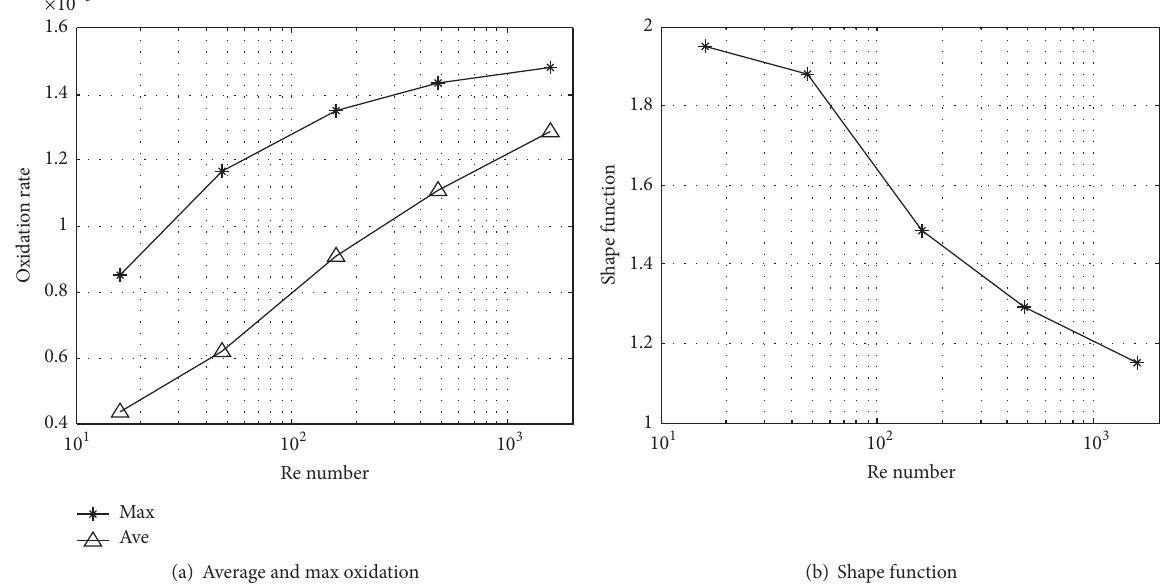
Figure 8: Shape function with different Re number ( 𝑇 = 800 ∘